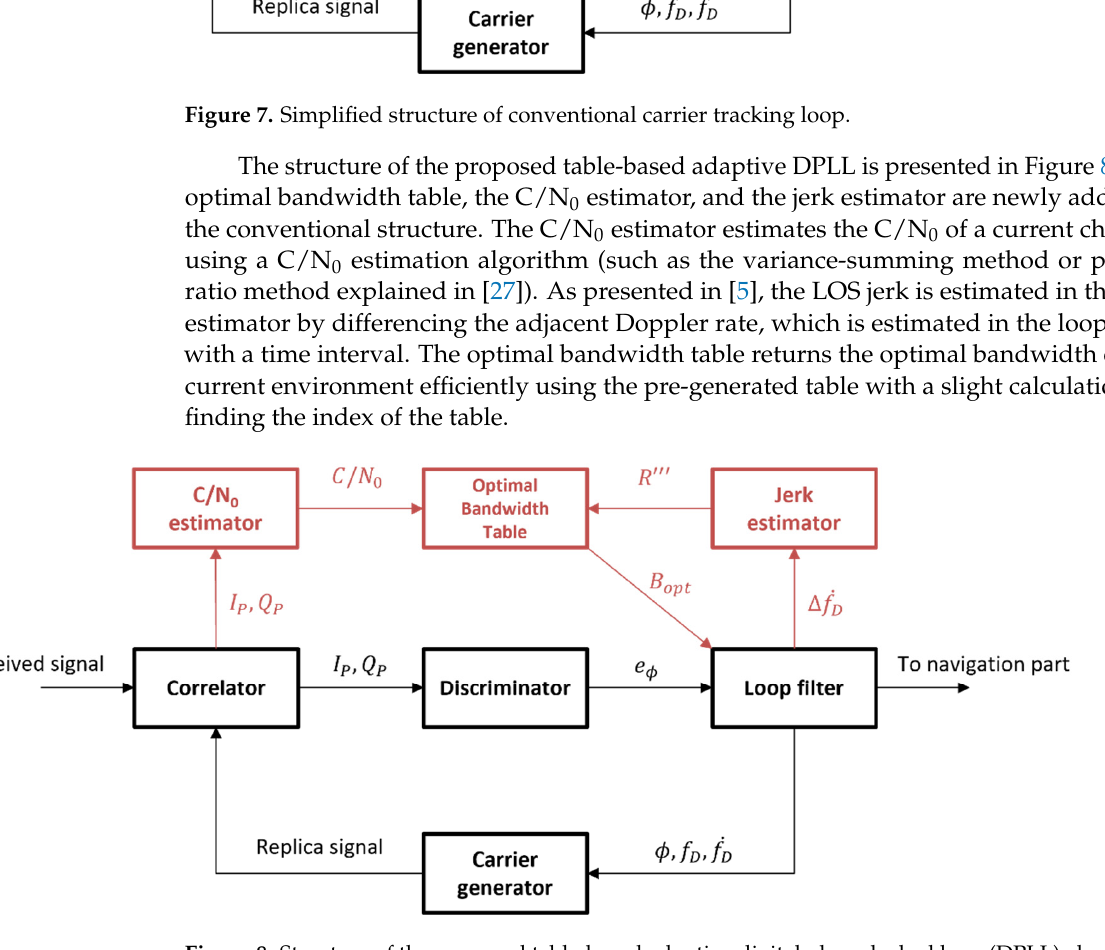
Figure 8. Structure of the proposed table-based adaptive digital phase-locked loop (DPLL) algo- rithm.